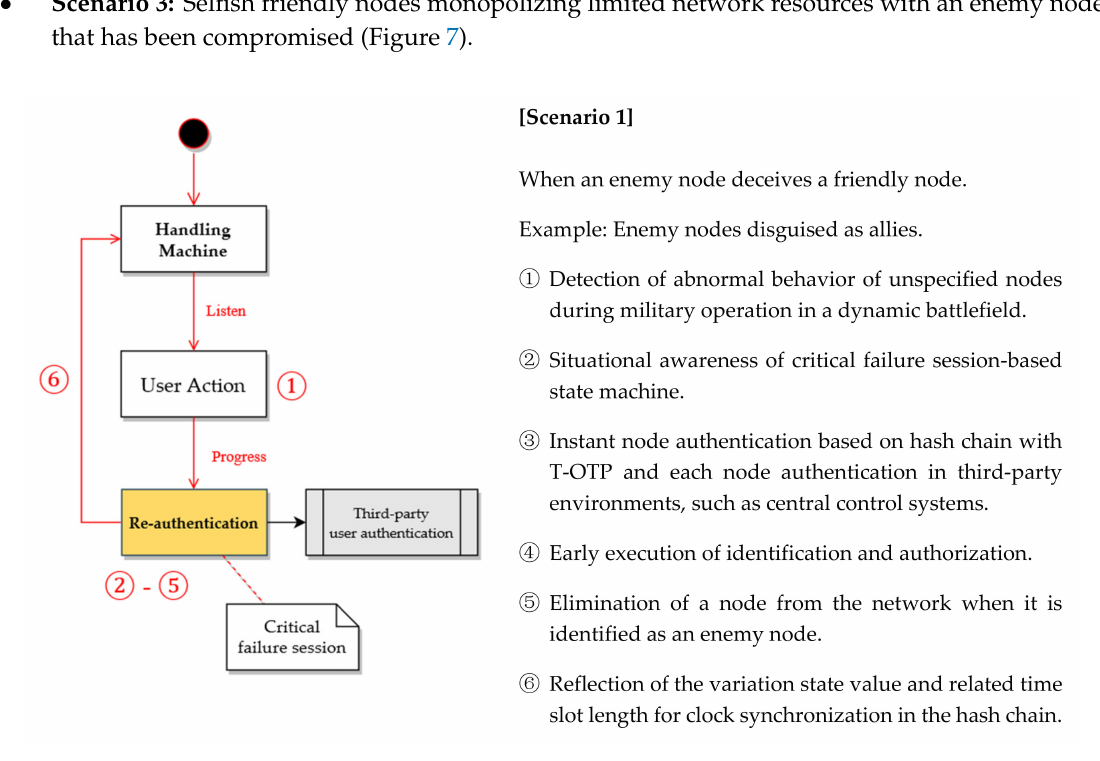
Figure 5. Scenario 1—based exception handling flows.